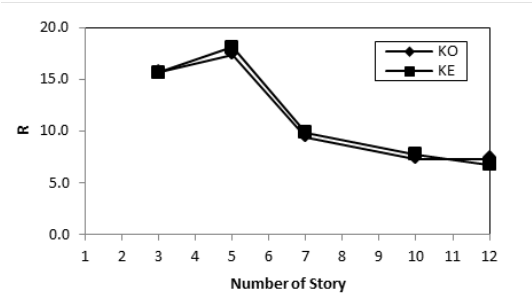
Fig. 13. Number of story- response modification